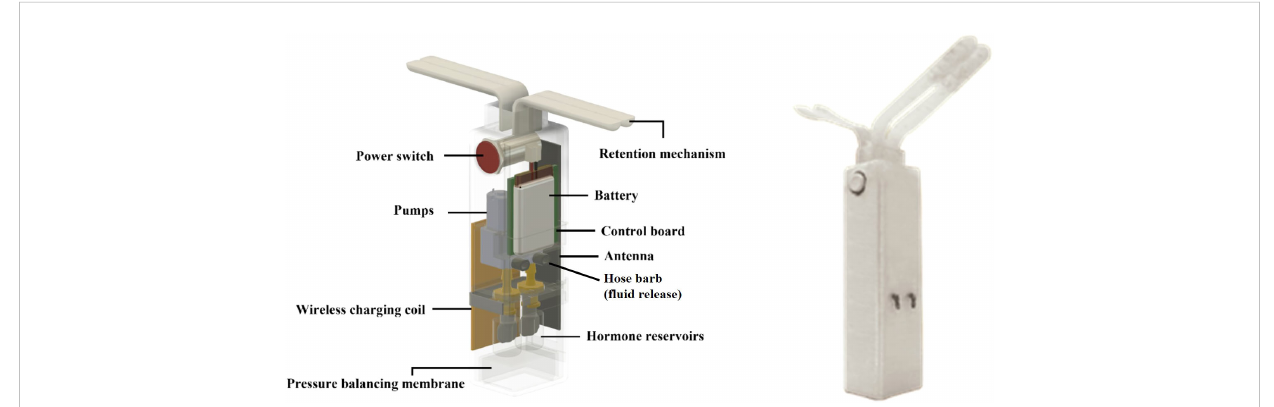
FIGURE 2 3D model (left) of the e-Synch device and its components and fully assembled e-Synch device (right). e-Synch consists of an outer case 3D-printed, with two double Nylon wings for retention, and a fl exible silicone membrane at the bottom for pressure balancing during drug delivery. A power switch and fl exible wideband antenna are placed on the side. Internal components include a central control board and two silicone hormone reservoirs with ~5 mL capacity connected to individual peristaltic pumps through a Luer lock connection. Polyethylene elbows with hose barb are connected to each peristaltic pump and placed onto one of the laterals of the device. A Lipo battery is sealed inside the case to provide power. A Qi wireless charging coil with a receiver module is attached to the external side of the device to serve as a power input for the micro-Lipo charger through a sealed hole.